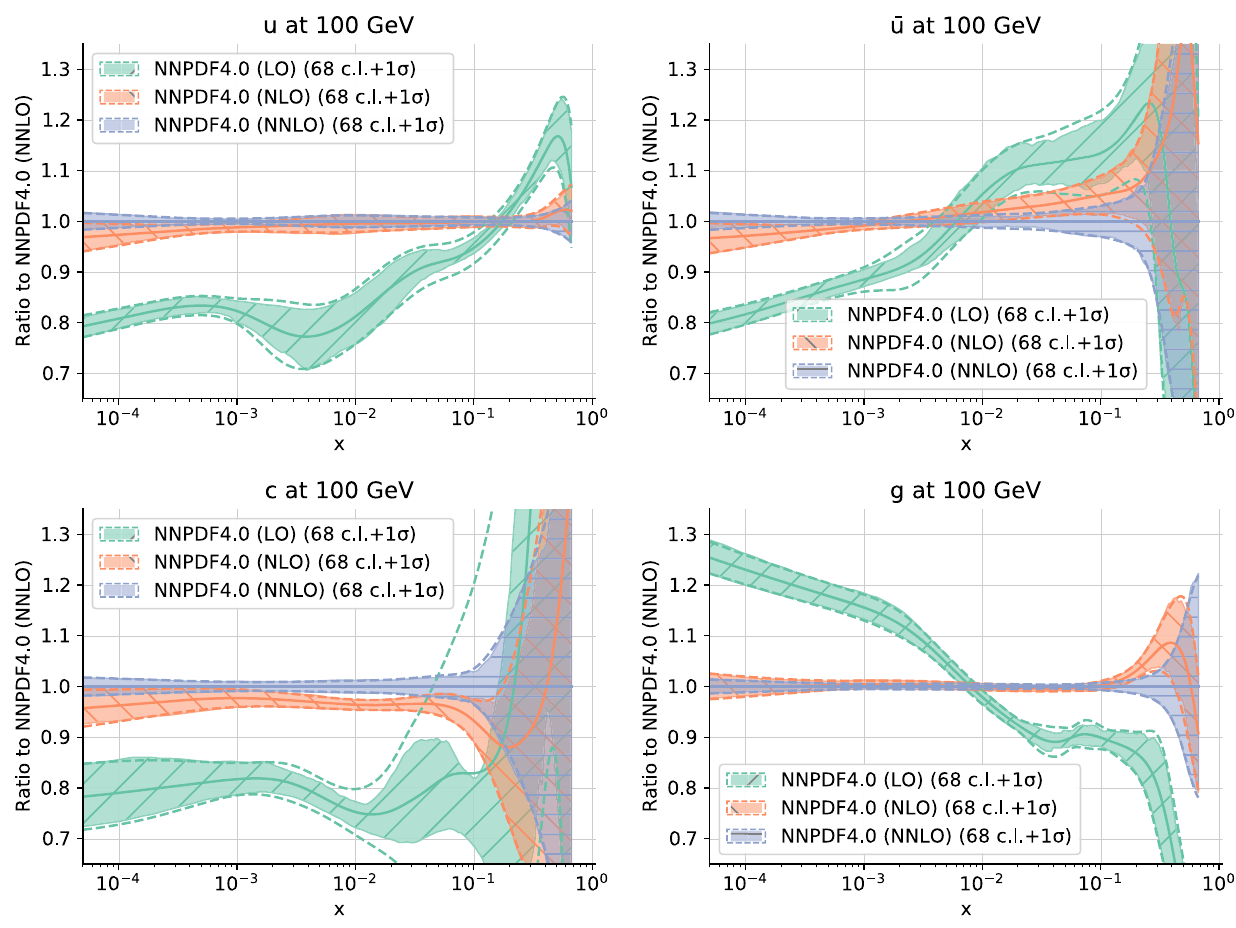
Fig. 19 Comparison between the LO, NLO and NNLO NNPDF4.0 PDFs. The up, antiup, charm and gluon are shown at Q = 100 GeV. All results are normalized to the central value of the NNLO set. Solid and dashed bands correspond respectively to 68% c. l. and one-sigma